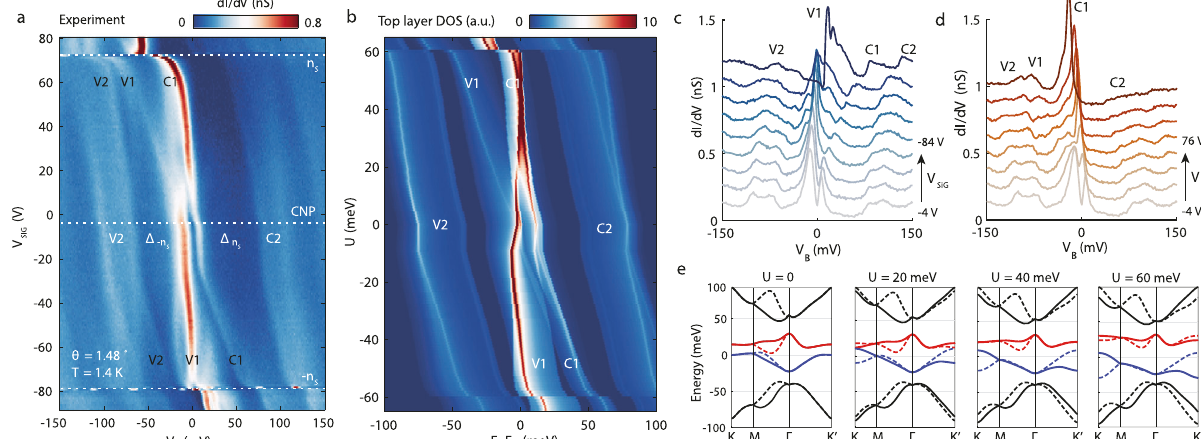
Fig. 3 Tunable band structure of TDBG. a Differential tunneling conductance as a function of bias voltage V B and silicon gate V SiG measured near the ABAB stacking con fi guration, with V set = − 400 mV, I set = 400 pA and AC modulation of V mod = 3 mV. The white dashed lines mark the charge neutral point (CNP) and full fi lling of C1 ( n S ) and V1 (- n S ) bands. b Calculated top graphene layer density of state as a function of energy respect to Fermi energy E – E F and onsite potential difference between the top and bottom graphene layer U . A different bias range is used in panel b (±100 meV, instead of ±150 meV in panel a ) to make the best visual comparison with panel a . This energy mismatch with experimental features could be caused by electron interactions, which are not accounted for in the theory or inaccurate model parameters. c , d line spectra from CNP to full hole ( c ) and electron ( d ) fi lling. e Band structure at different U in the mini-Brillouin zone, red (blue) lines represent the fi rst conduction (valence band). The solid and dashed lines correspond to two different valleys K 1 and K 2 of the Brillouin zone of the graphene